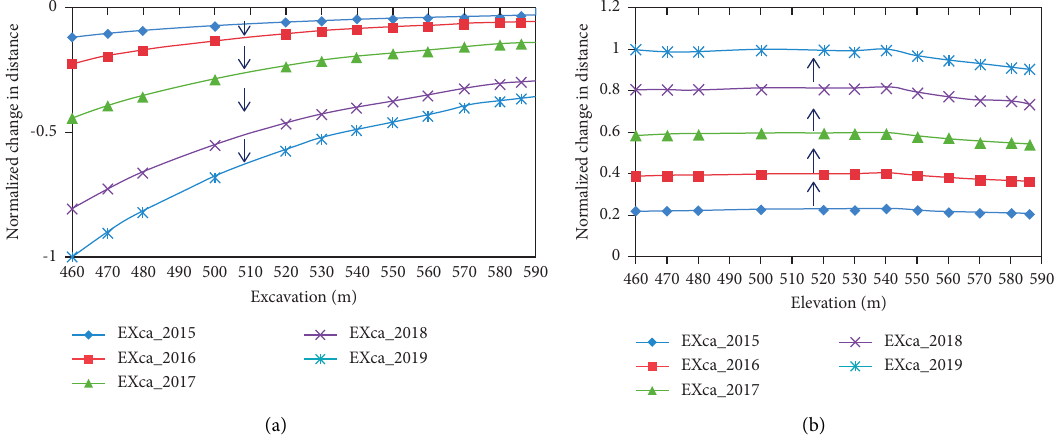
Figure 15: Normalized change in distance of the simulated results of displacement induced by (a) release of horizontal stress and (b)